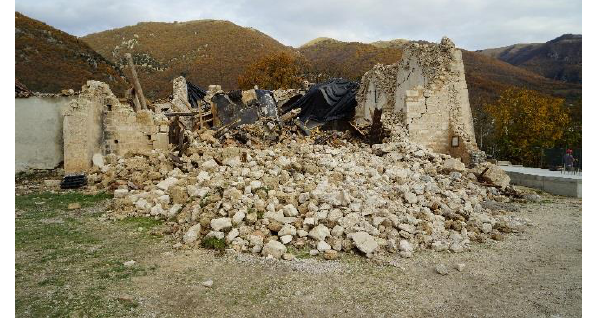
Figure 3. San Salvatore Church ruins.